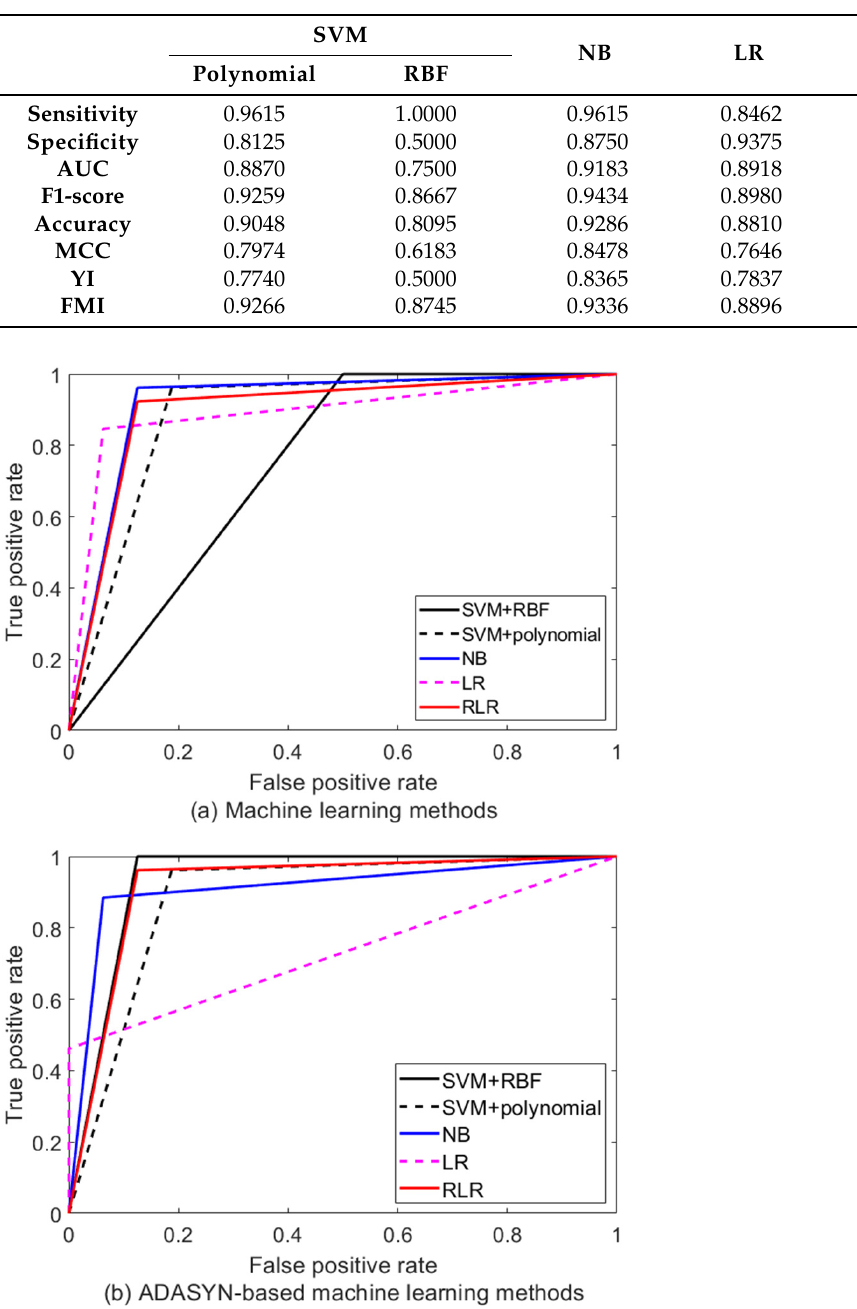
Figure 5. ROC curve of machine-learning methods and ADASYN-based machine-learning